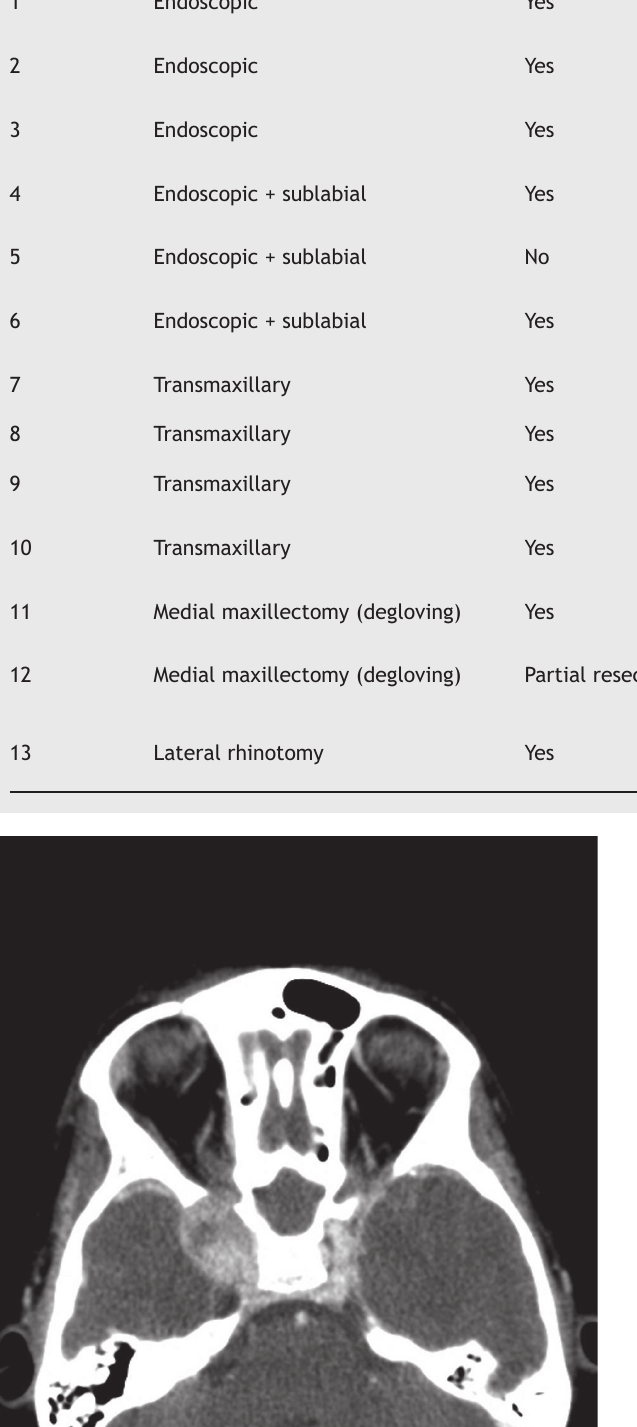
Table 1 Summary of surgical routes and postoperative complications. Patient